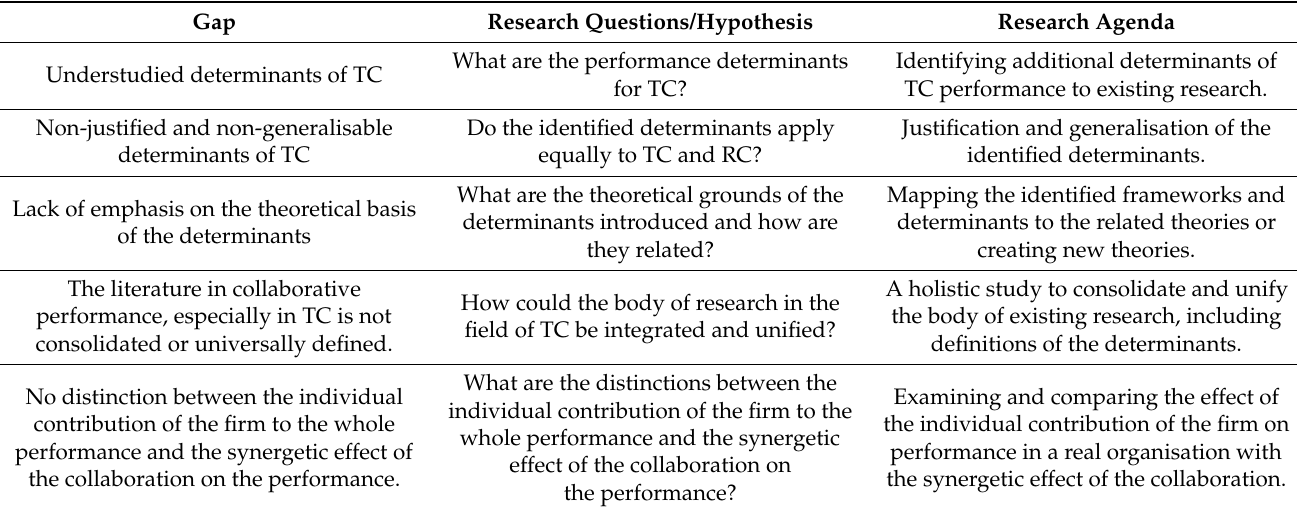
Table 6. The gap in research and future research